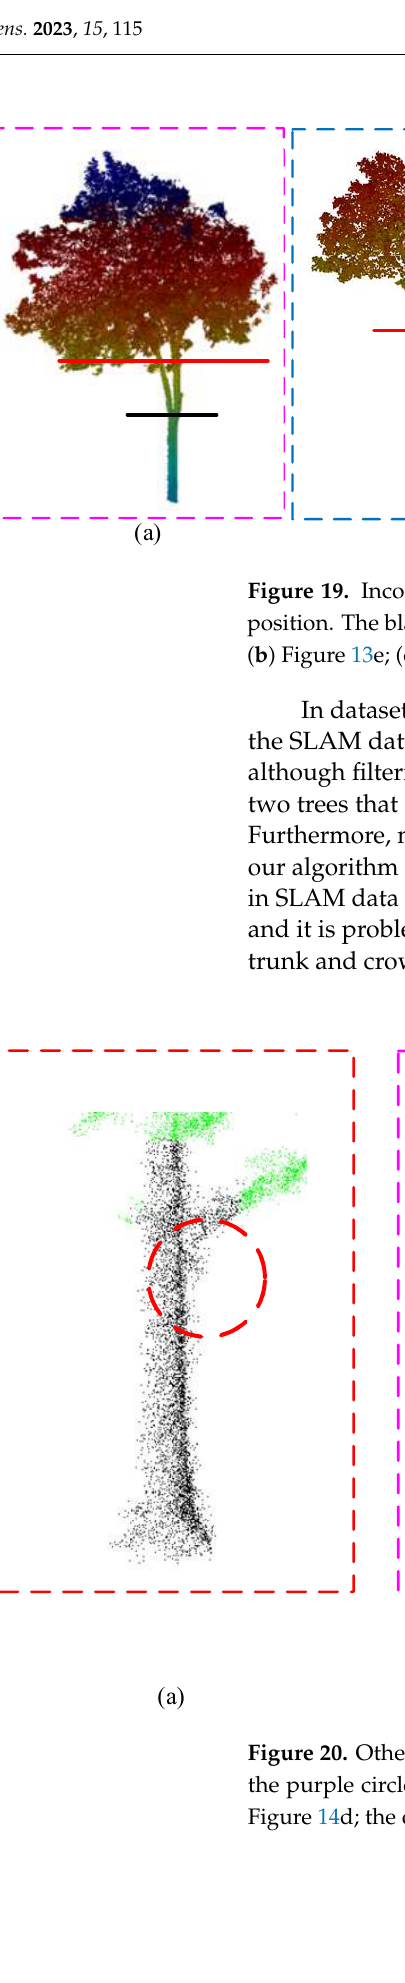
Figure 18. Mis-segmentation cases: ( a ) Manual denoising of Figure 12c; ( b ) The effect of trunk ex- traction; ( c ) Circle segmentation results of Figure 13c; ( d ) Circle segmentation results of Figure 15d. (The purple rectangles indicate the acquired reference slices and the red rectangles indicate the circle segmentation results in ( c , d ).